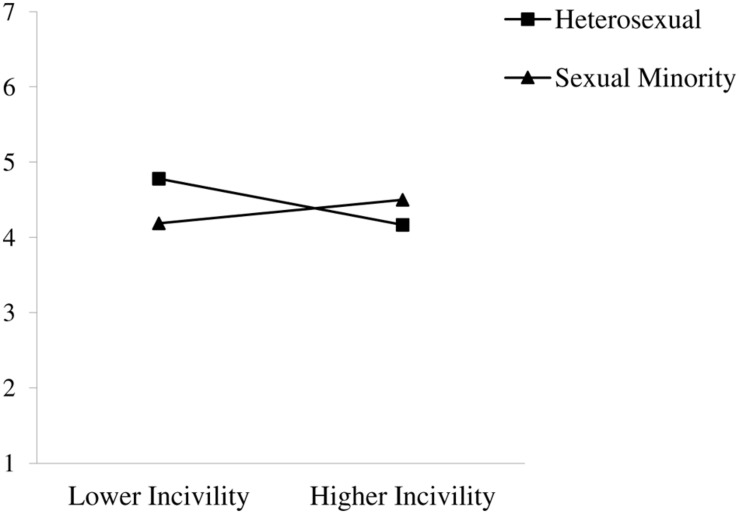
Interaction of workplace incivility and sexual orientation on job identity centrality.